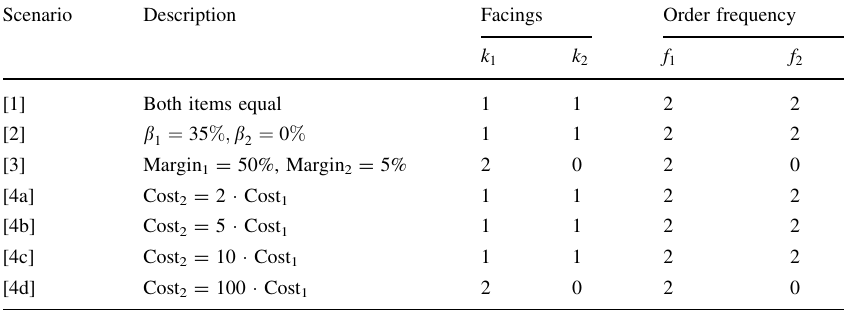
Table 8 Assortment changes depending on margin, space elasticity and cost